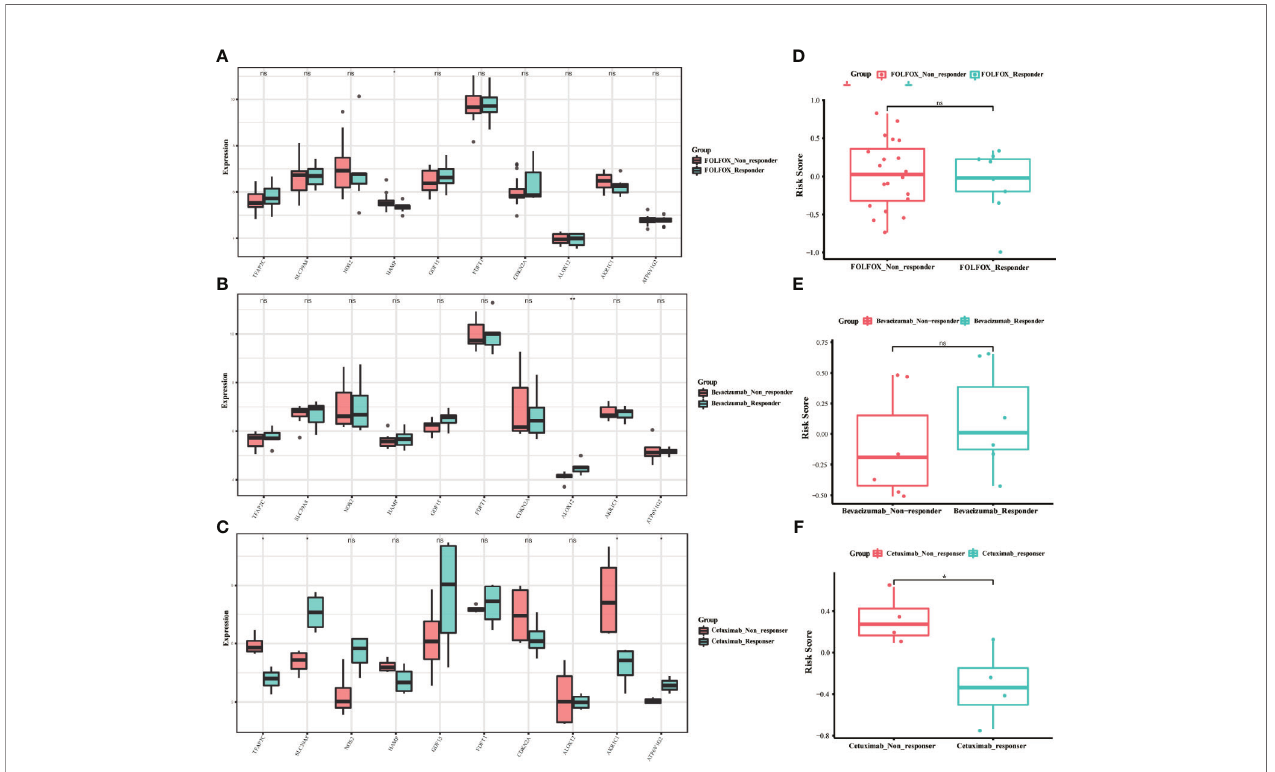
FIGURE 9 | The boxplots of the different expression levels of the 10 ferroptosis-related genes between the FOLFOX (A) , Bevacizumab (B) , and Cetuximab (C) responders and non-responders in the GSE19860, GSE19862 and GSE56386 datasets. The boxplots for the relationships between the risk scores and the drug resistance in the GSE19860 (D) , GSE19862 (E) and GSE56386 (F) datasets. *p < 0.05, **p < 0.01. ns, no signi fi